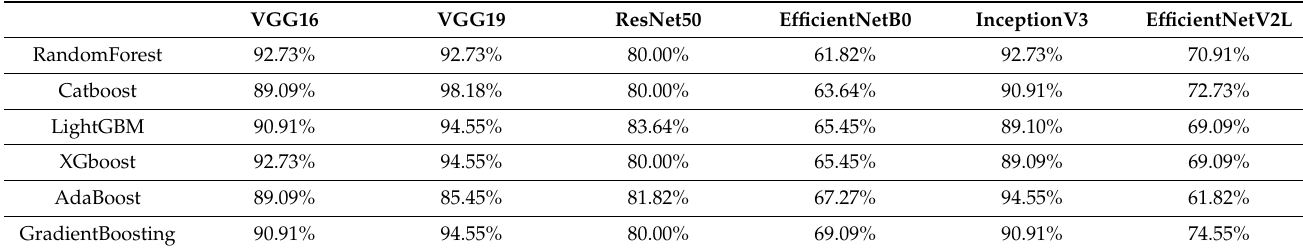
Table A18. Accuracy of each model combination for blue ovals.